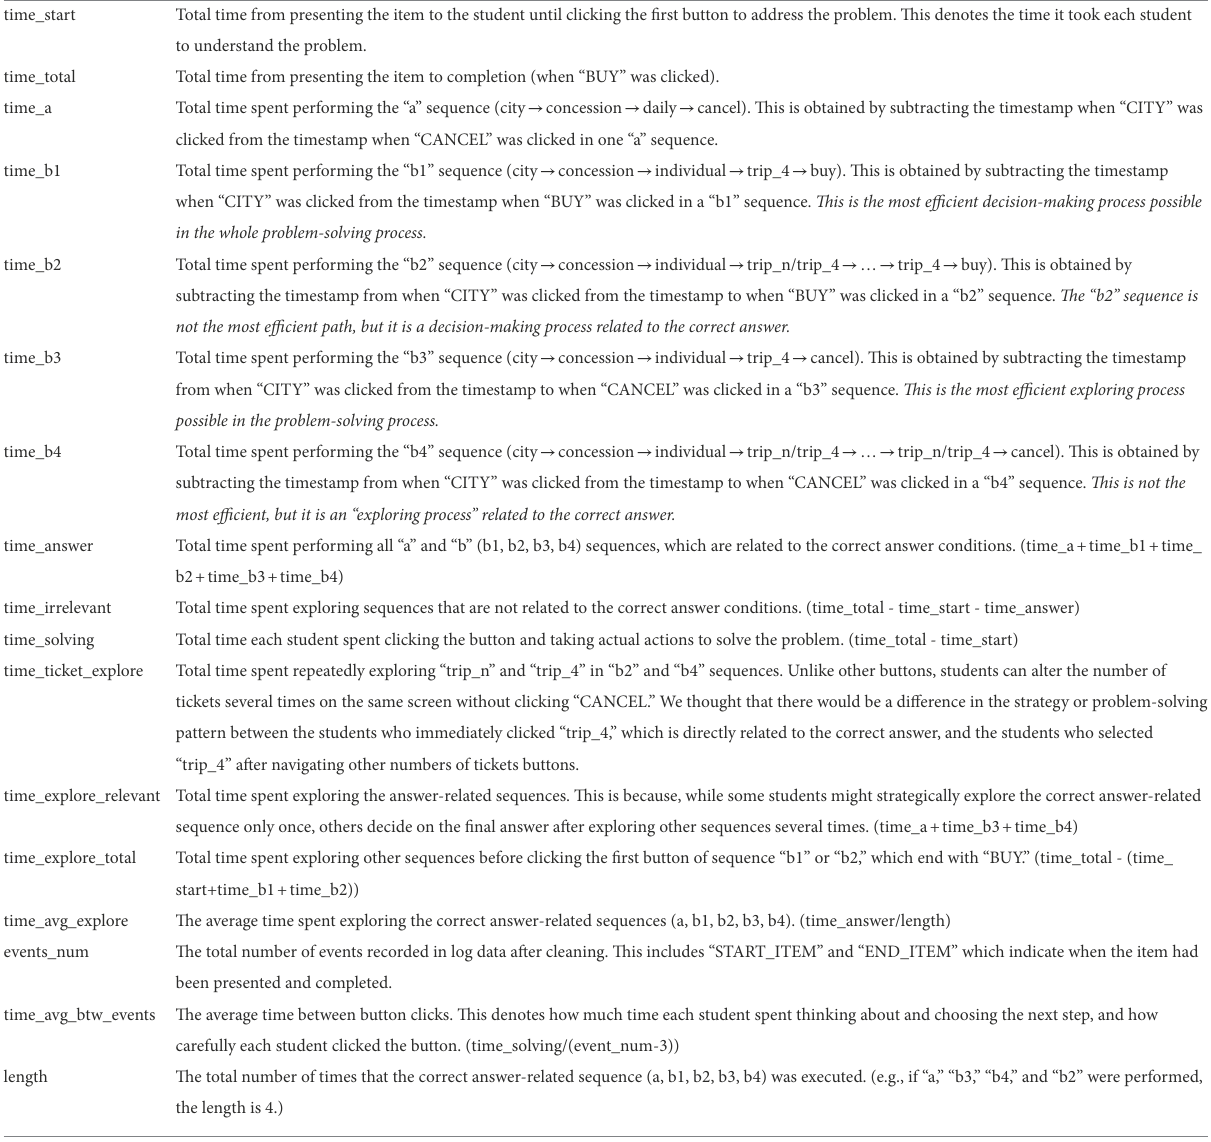
TABLE 2 List of variables and their